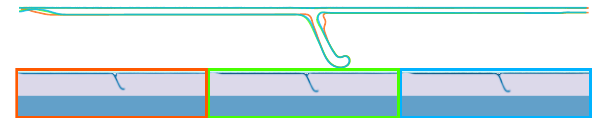
Figure 11. 1550K isotherm for models 3 (left/orange), 5 (cen- ter/green), and 7 (right/blue). Surface plates are 50km thick and have a maximum viscosity of 10 23 Pas, 10 24 Pas, and 10 25 Pas for models 3, 5, and 7 respectively. Slabs have a maximum viscosity of 10 23 Pas. Subfigures show viscosity for each